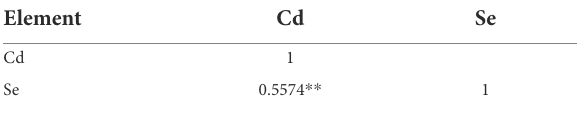
FIGURE 3 Histogram of soil Se content in the study area. TABLE 1 Correlation matrix of Cd and